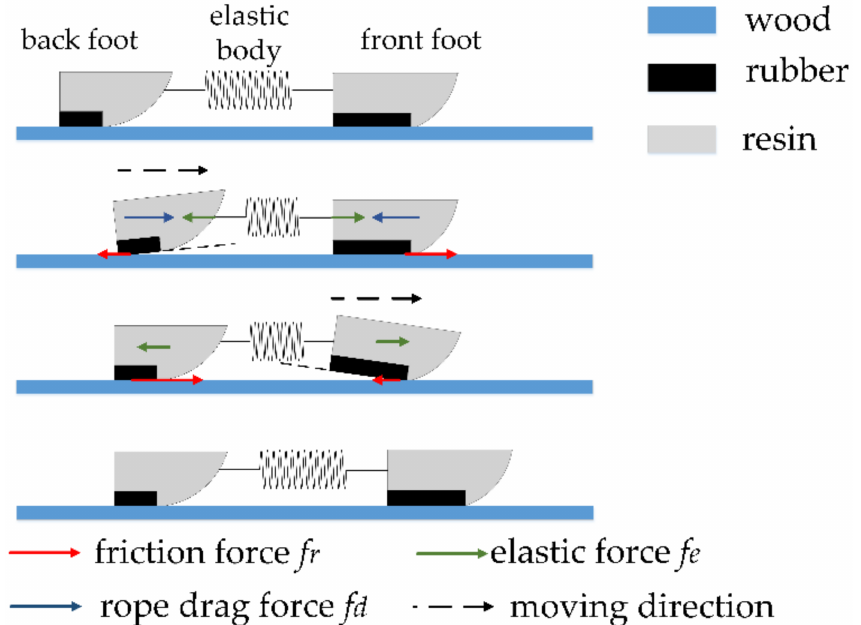
Figure 19. Schematic view of the friction force and moving status of rubber sliding feet with forward motion in one working